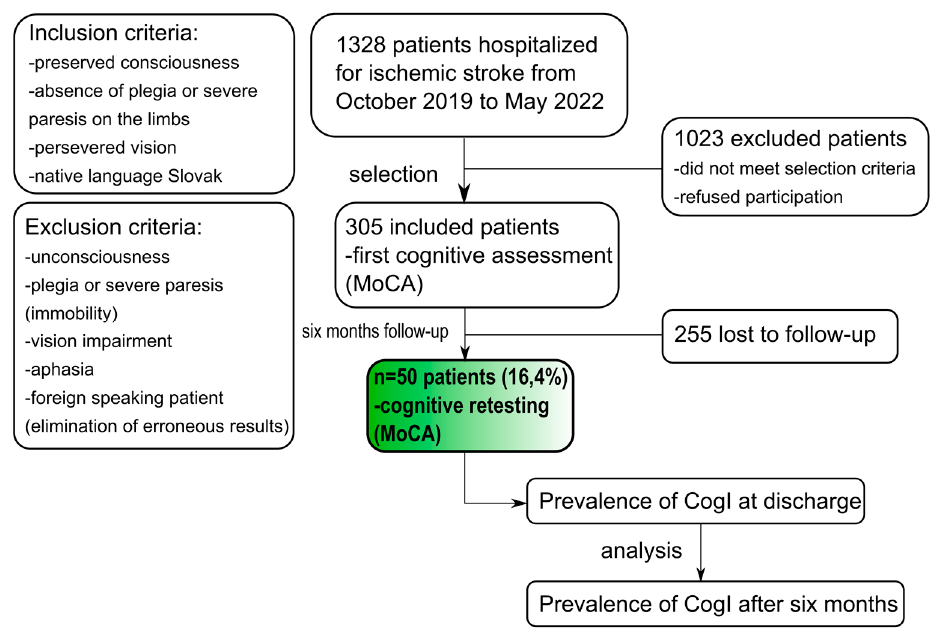
Figure 1. Flowchart of patients’ recruitment with selection (inclusion and exclusion) criteria.